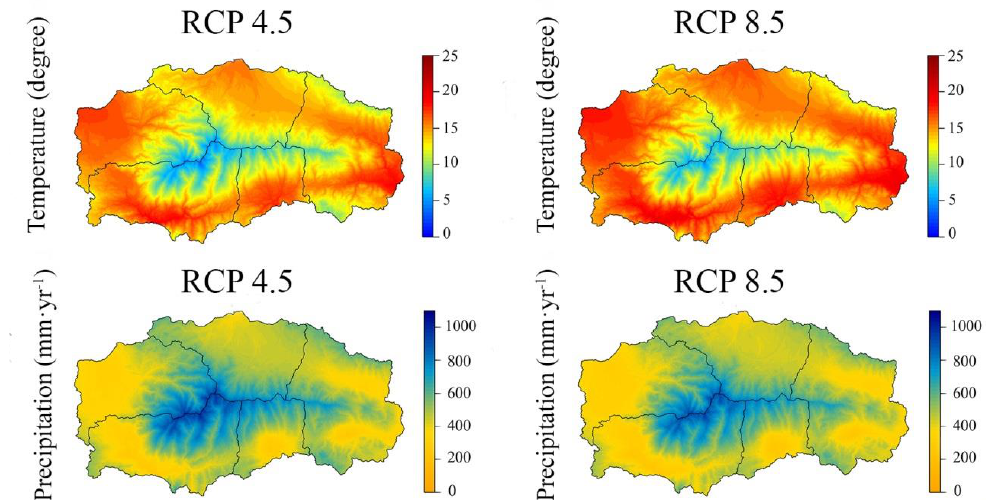
Figure 5. Spatial distribution of the mean daily temperature and the mean annual precipitation for the two global change scenarios analyzed during the 2006–2010 period in the study area.